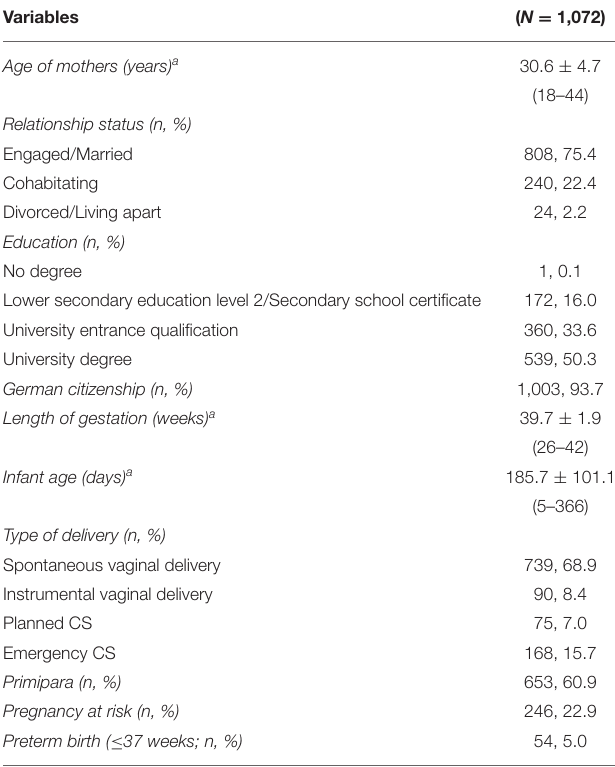
TABLE 1 | Sociodemographic and obstetric characteristics of the sample.